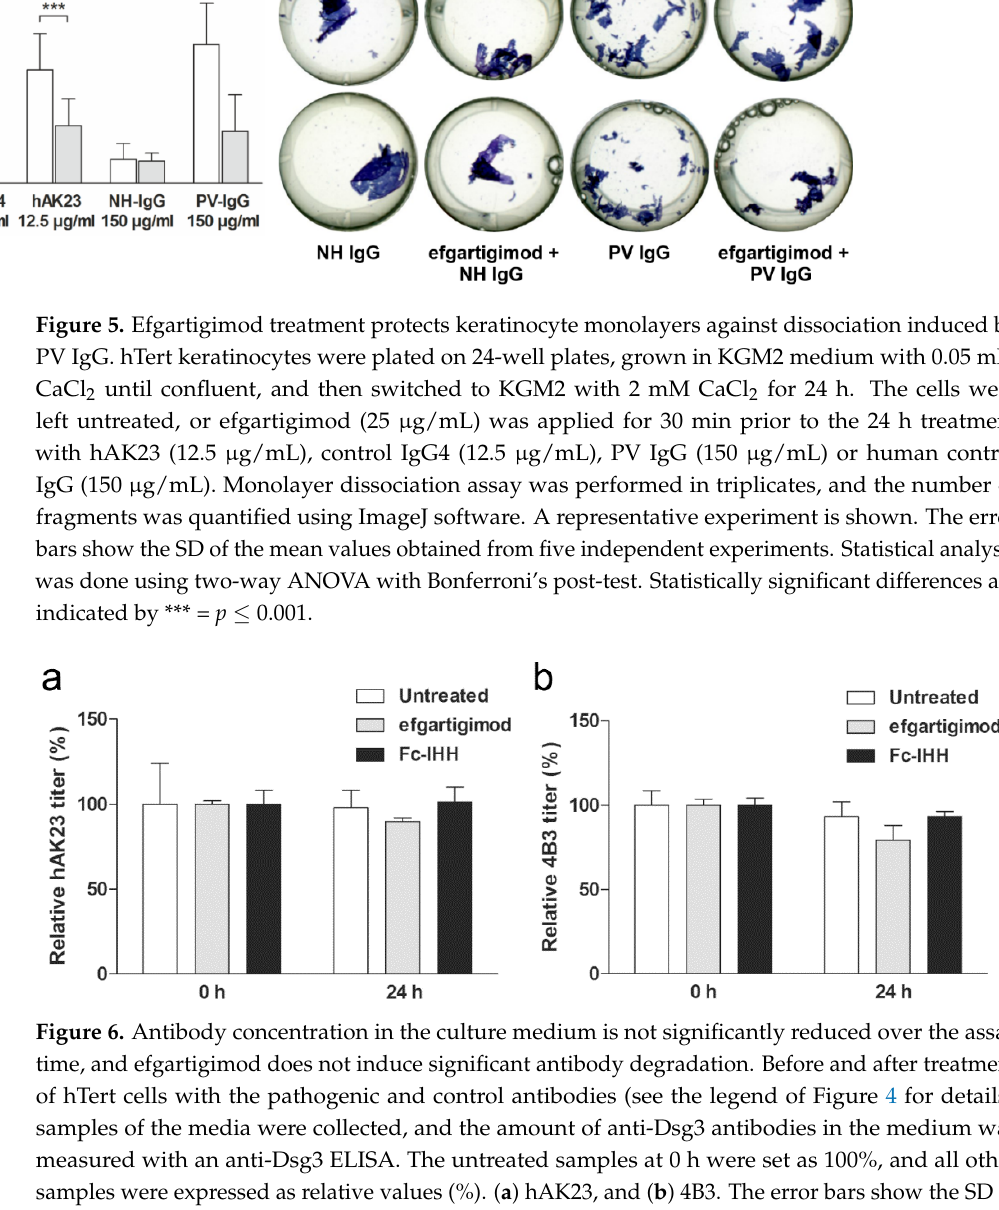
13 of 24 Figure 4. Efgartigimod treatment protects keratinocyte monolayers against dissociation induced by hAK23 and 4B3 anti-Dsg3 antibodies. hTert keratinocytes were plated on 24-well plates, grown in KGM2 medium with 0.05 mM CaCl 2 until confluent, and then switched to KGM2 with 2 mM CaCl 2 for 24 h. The cells were left untreated, or efgartigimod, Fc-WT or Fc-IHH (all at final concentration of 25 µg/mL) was applied for 30 min prior to the 24 h treatment with the respective recombinant